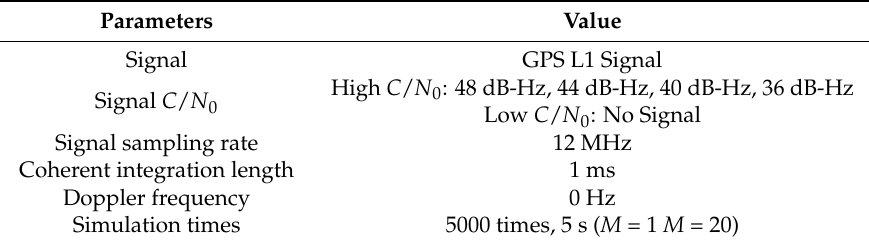
Table 1. Simulation parameters of software